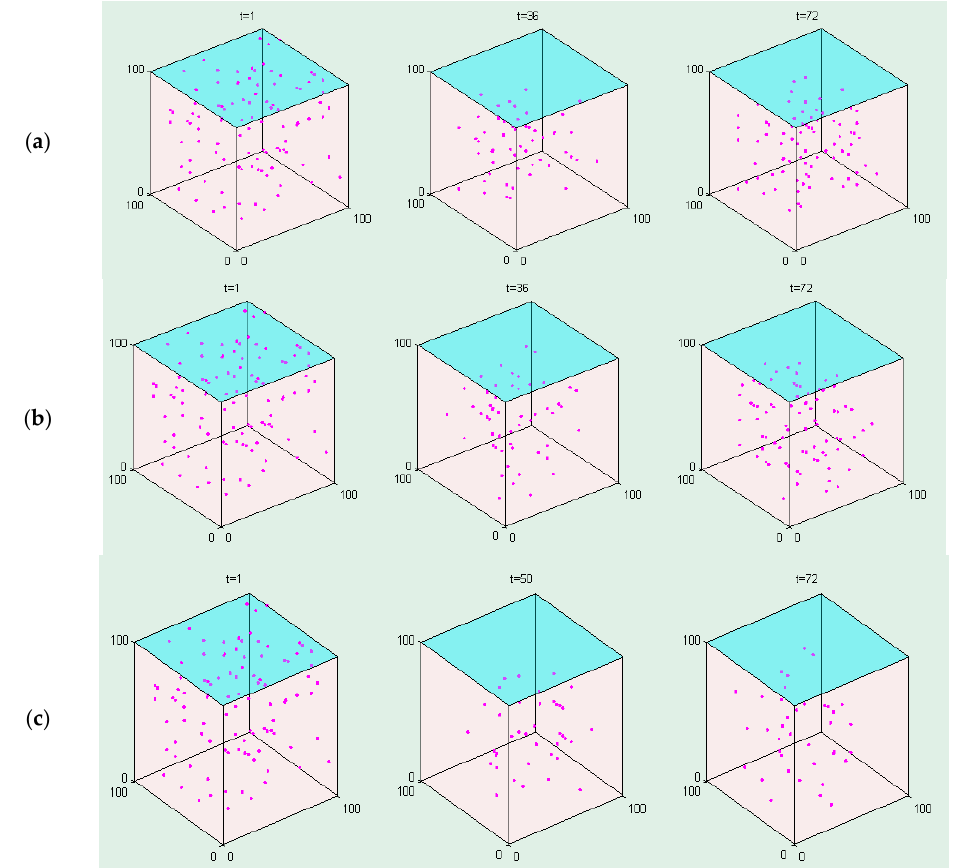
Figure 3. The spatial information of cancer cells under the impact of the ( a ) gefitinib and rosiglitazone; ( b ) erlotinib and imatinib; ( c ) gefitinib and quinacrine. The initial drug ratios between these drug pairs are 1:4.